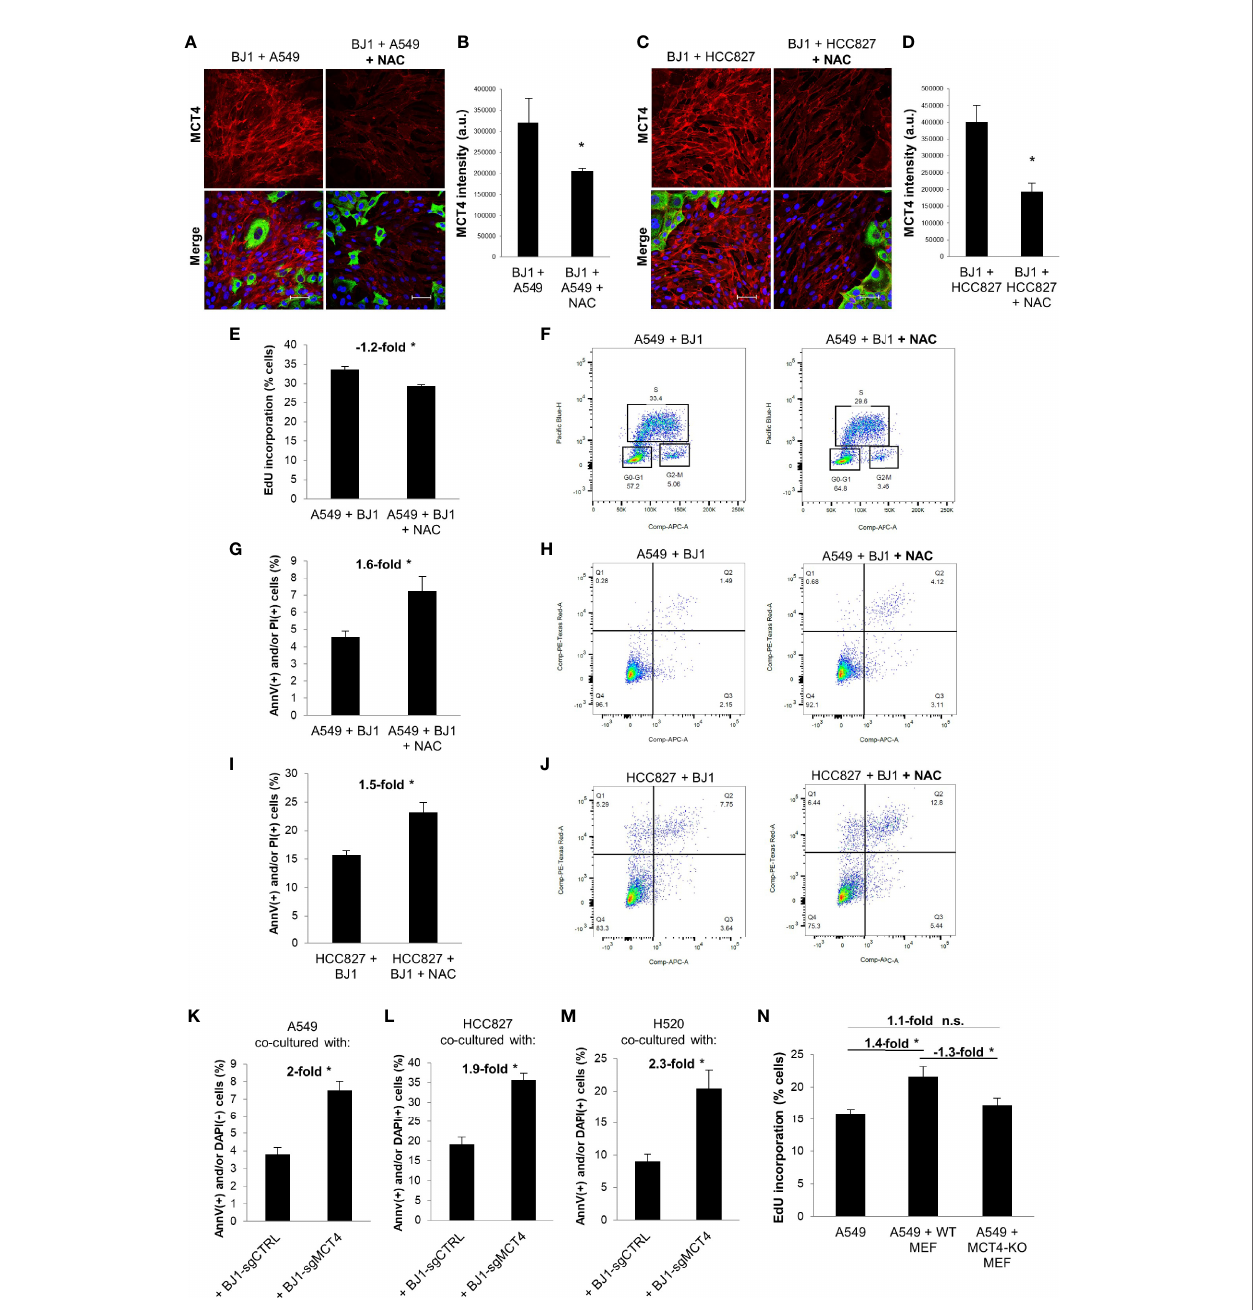
FIGURE 6 | Effects of ROS neutralization and MCT4 downregulation on fi broblast metabolism and ADT carcinoma cell aggressiveness. Co-cultures of ADT carcinoma cells with BJ1 were treated with N-acetyl cysteine (NAC) for 24 hours for proliferation assessments, and for 48 hours for confocal imaging and apoptosis assessment. (A – D) Confocal imaging of MCT4 in co-cultures of BJ1 with A549 (A) and HCC827 (C) treated or untreated with NAC, and respective quanti fi cation of MCT4 staining in BJ1 (B, D) . Confocal microscopy images were acquired at the 40X magni fi cation. For all images, MCT4 staining is shown in red, carcinoma cells are shown in green (K8/18 staining), and nuclei are shown in blue (DAPI). MCT4 staining was quanti fi ed using ImageJ. (E, F) Flow cytometry quanti fi cation of percentage of A549 cells in the DNA synthesis phase, measured by 5-ethynyl-2 ’ -deoxyuridine (EdU) incorporation (E) , and gating strategy for EdU (Paci fi c Blue) and FxCycle (APC) staining (F) . (G – J) Flow cytometry assessment of percentage of carcinoma cells undergoing apoptosis (AnnV staining) and cell death (PI staining) in co-cultured A549 (G, H) and HCC827 (I, J) cells untreated or treated with NAC with representative fl ow cytometry plots showing gating strategy for AnnV (APC) and PI (PE) staining. (K – M) ADT carcinoma cells were co-cultured with mCherry-tagged BJ1 with downregulated MCT4 expression (BJ1-sgMCT4) or their control counterparts (BJ1-sgCTRL) and apoptosis (AnnV staining) and cell death (DAPI staining) was assessed in A549 (K) , HCC827 (L) and H520 (M) by fl ow cytometry. (N) GFP-tagged A549 were monocultured or co-cultured with WT or MCT4-KO MEFs and proliferation rates in A549 were assessed by fl ow cytometric analysis of EdU incorporation. Student ’ s t-test was used for statistical analyses (*p<0.05). (a.u., arbitrary units. Scale bar = 50 m m). ns, not signi fi